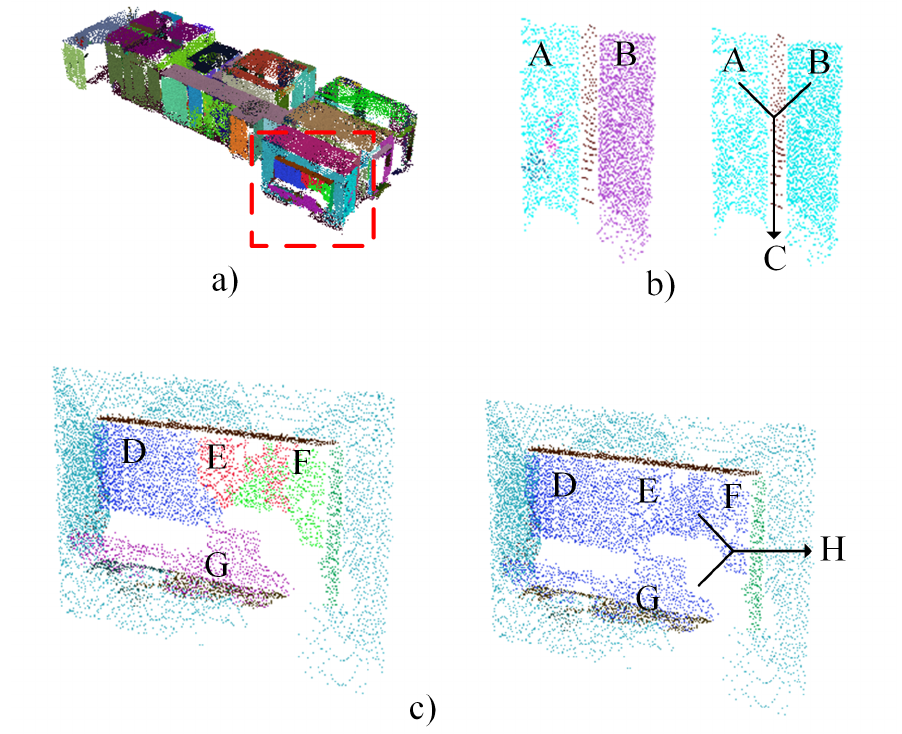
Figure 4. The results of plane refinement: ( a ) The point clouds before refinement, ( b ) plane A and plane B have been merged to plane C, and ( c ) planes D, E, F, and G have been combined into plane H. They are actually parallel planes (not belonging to the same